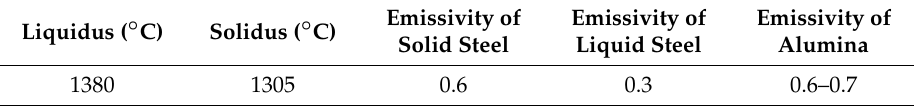
Table 1. Summary of expected properties of the materials used in this study.